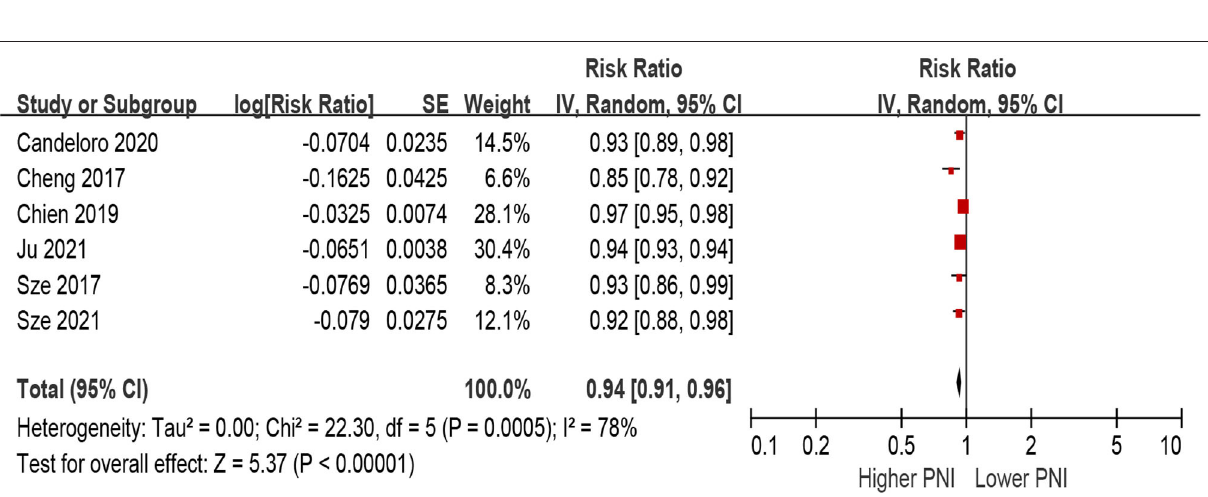
FIGURE 5 | The association between PNI (defined as per 1 increment) and the risk of all-cause mortality in HF (multivariable-adjusted model). CI, confidence interval; HF, heart failure; PNI, prognostic nutritional index.